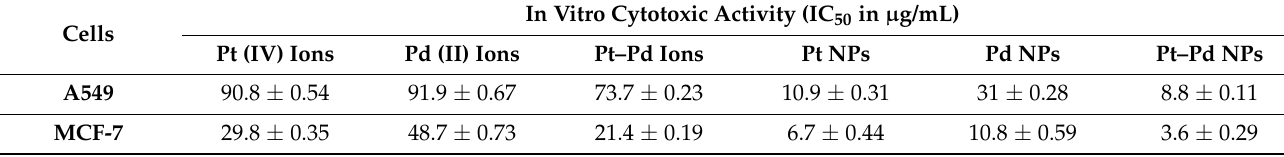
Table 1. In vitro cytotoxic activities of P. harmala seed alkaloid fraction mediated Pt NPs, Pd NPs, and Pt–Pd NPs compared to their individual metal ions against A549 lung cancer cells and breast adenocarcinoma cells (MCF-7). In Vitro Cytotoxic Activity (IC 50 in µ Cells